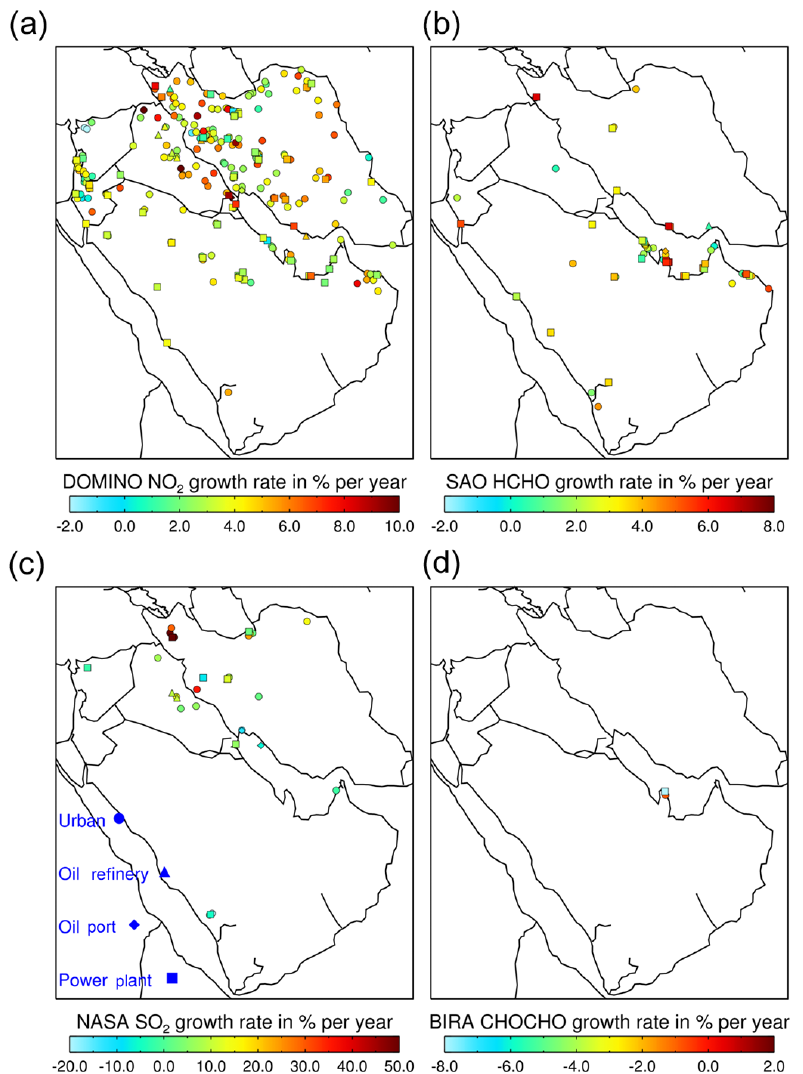
Figure 5. Geographical distribution of locations with statistically significant linear trends in NO 2 (a) , HCHO (b) , SO 2 (c) , and CHOCHO (c) , but here showing the growth rate expressed in percent per year, relative to each location’s 2005–2014 median vertical